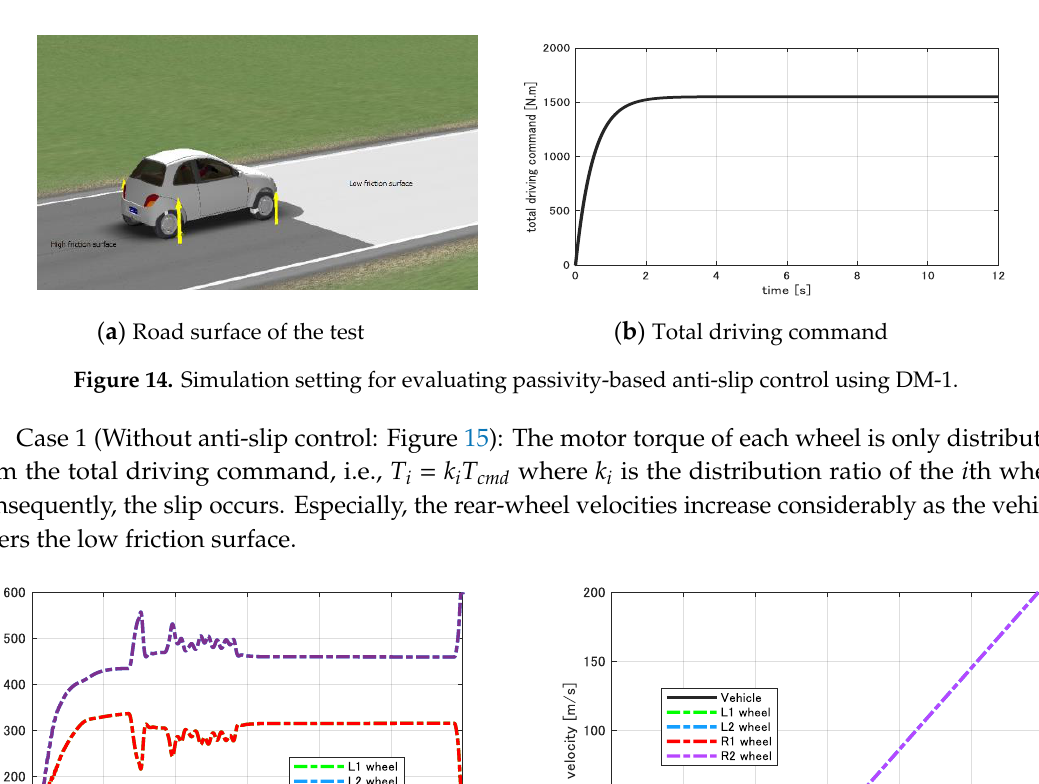
Figure 15. Simulation results of Case 1: without anti-slip control.